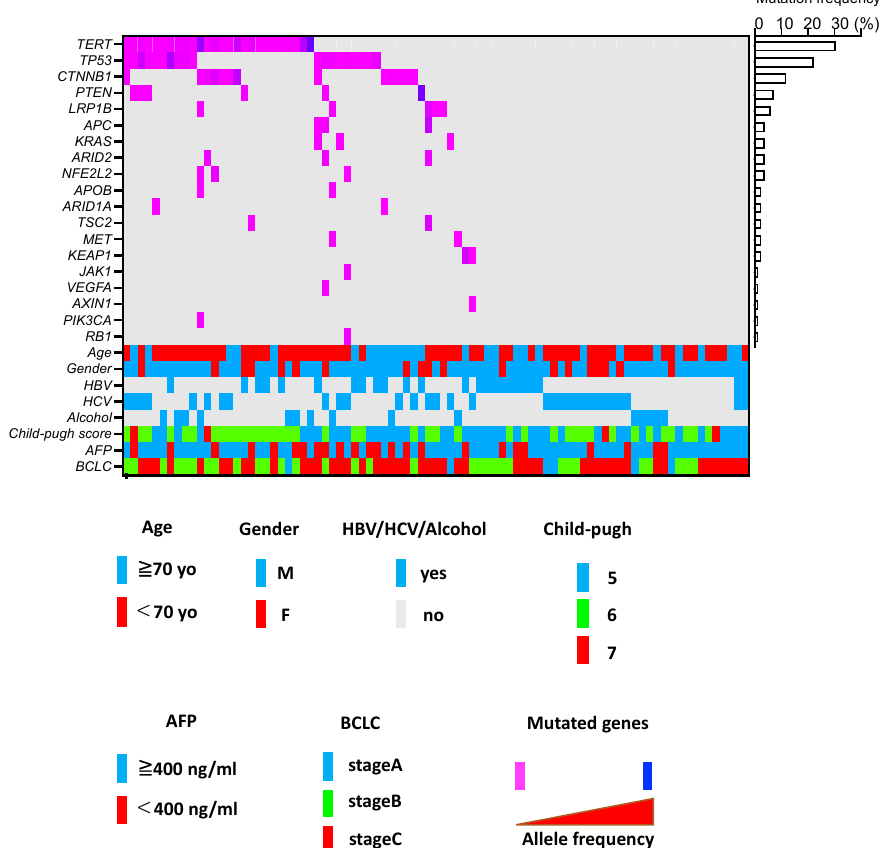
Figure 3. ctDNA profiling of u-HCC patients treated with Atezo/Bev. A heatmap showing the genomic profiling of baseline ctDNA in 85 u-HCC patients treated with Atezo/Bev. Single nucleotide variants are shown in a color scale of variant allele frequency. Genes are listed in the order of mutation frequency. Bottom panel shows age, gender, etiology of background liver disease, Child-Pugh score, AFP level and BCLC stage. ctDNA, circulating tumor DNA; u-HCC, unresectable hepatocellular carcinoma; Atezo/Bev, Atezolizumab and bevacizumab.